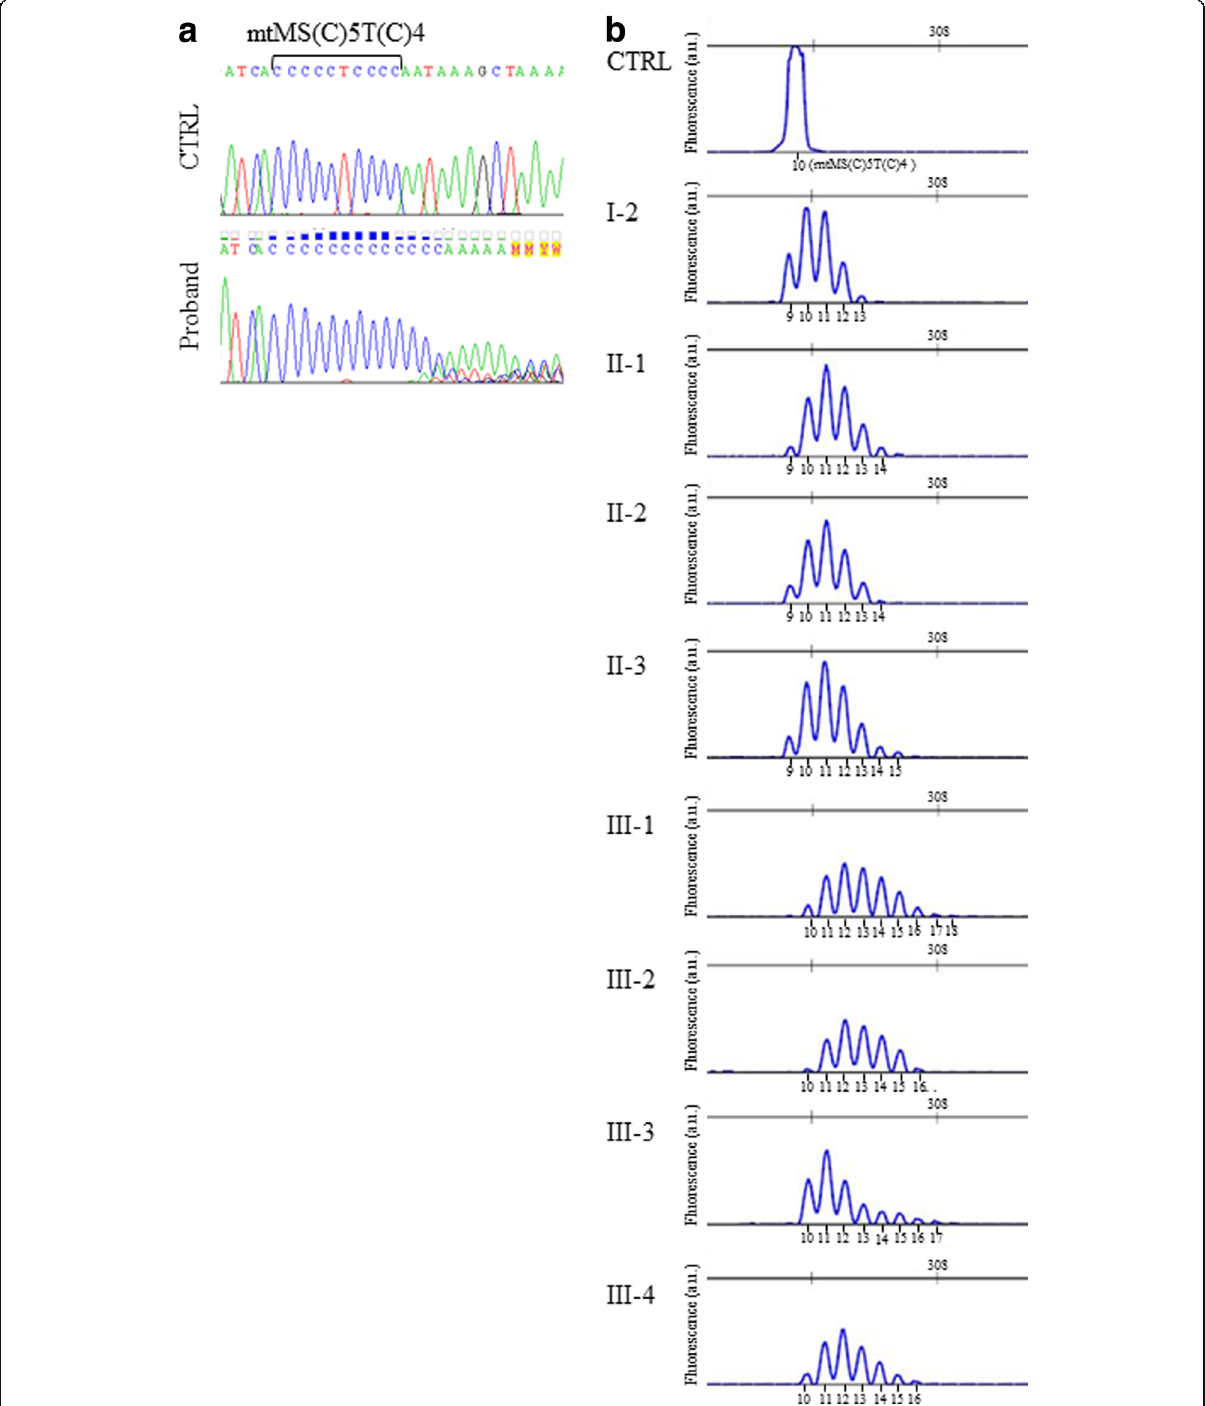
Fig. 2 Analysis of the C-microsatellite in LHON family. a Sanger sequencing of the mtMS region of the proband and control . b Fragment analysis of mtMS in all the maternal family